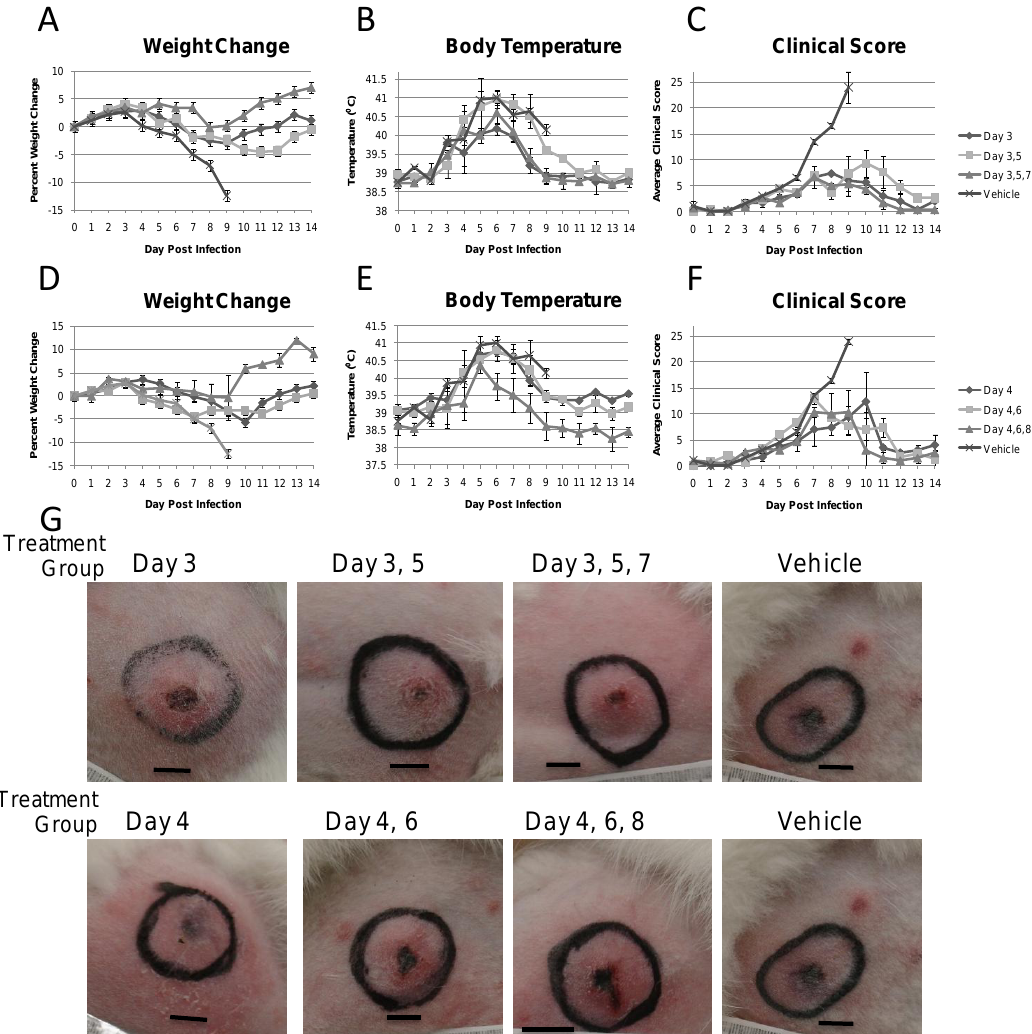
Figure 1. Clinical observations for evaluation of 1, 2 or 3 doses of CMX001 given every other day beginning at day 3 or 4 post infection. Animals were dosed at concentrations and schedules as outlined in Table 1. (A) Average weight change from weight at day of infection for animals that began treatment on day 3 post infection. Negative values indicated weight loss. (B) Average body temperatures for animals that began treatment on day 3 post infection. (C) Average clinical scores for animals that began treatment on day 3 post infection. (D) Average weight change from weight at day of infection for animals that began treatment on day 4 post infection. Negative values indicated weight loss. (E) Average body temperatures for animals that began treatment on day 4 post infection. (F) Average clinical scores for animals that began treatment on day 4 post infection. (G) Pictures of primary lesions (necrosis only) from representative animals at 7 dpi. Bars represent 1cm. Black circles denote site of intradermal